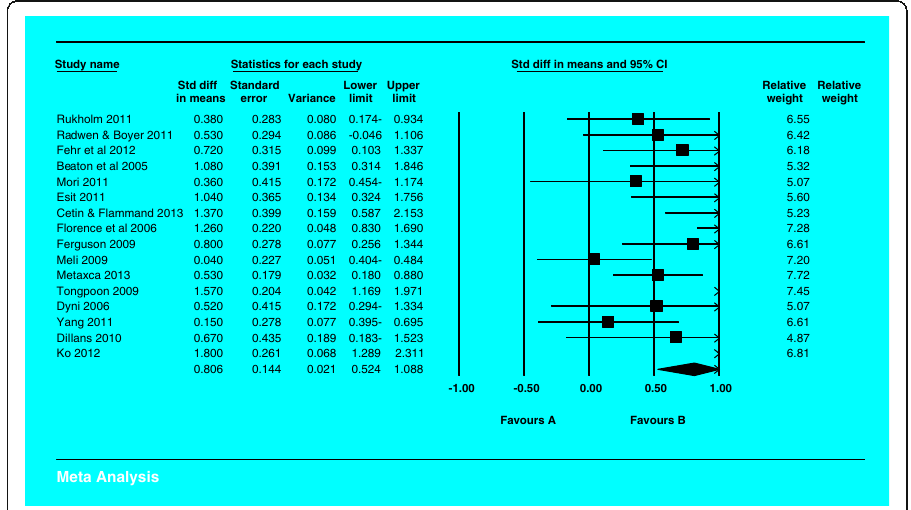
Fig. 1 Forest plot of standardized mean effect sizes for overall L2 vocabulary